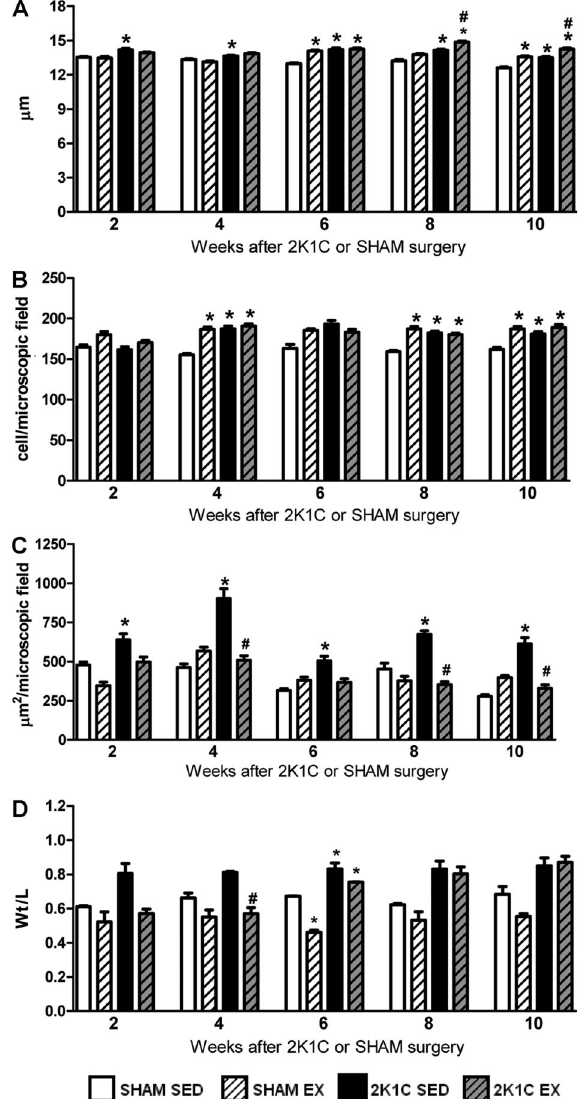
Figure 3. Cardiomyocyte diameter ( m m, A ), number of myocardial in fl ammatory cells per microscopic fi eld ( B ), myocardial collagen deposition ( m m 2 /microscopic fi eld, C ), and left ventricle wall thickness/lumen ratio (Wt/L, D ) of normotensive (SHAM, n=3 – 7) and hypertensive (2K1C, n=3 – 5) rats, either sedentary (SED) or subjected to physical exercise training (Ex), for 2, 4, 6, 8, and 10 weeks of swimming. *P o 0.05 compared to SHAM SED rats. # P o 0.05 compared to 2K1C SED rats (two-way ANOVA followed by Bonferroni